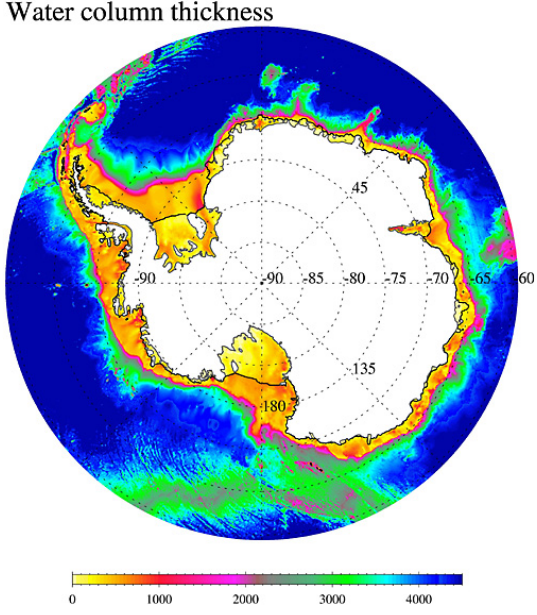
Figure 8. Water column thickness in the Southern Ocean sector of